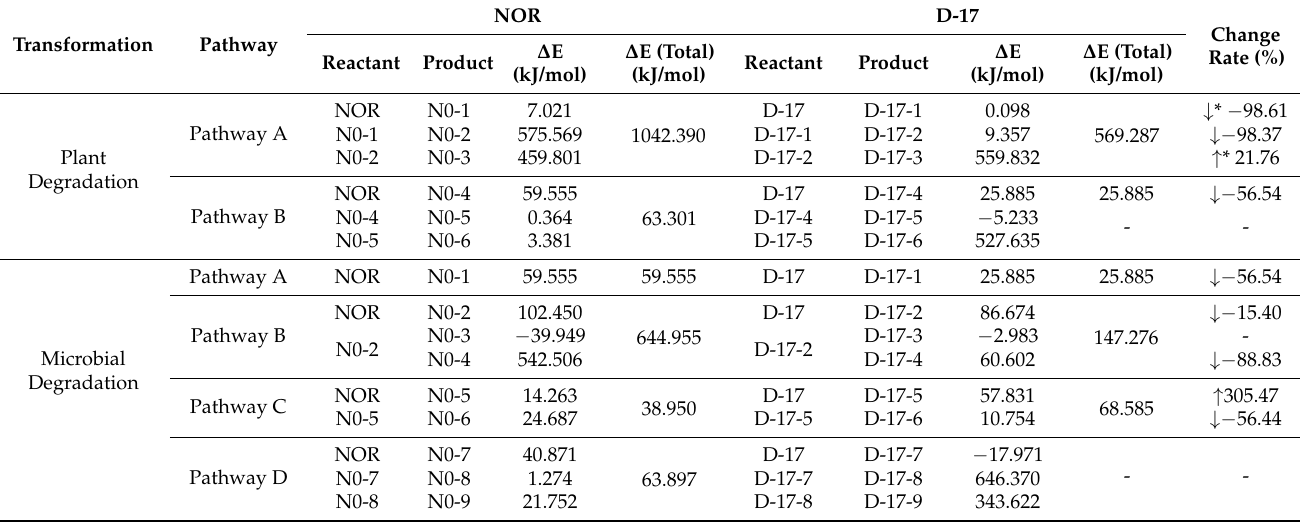
* “ ↓ ” indicates that the value decreases, and “ ↑ ” indicates that the value